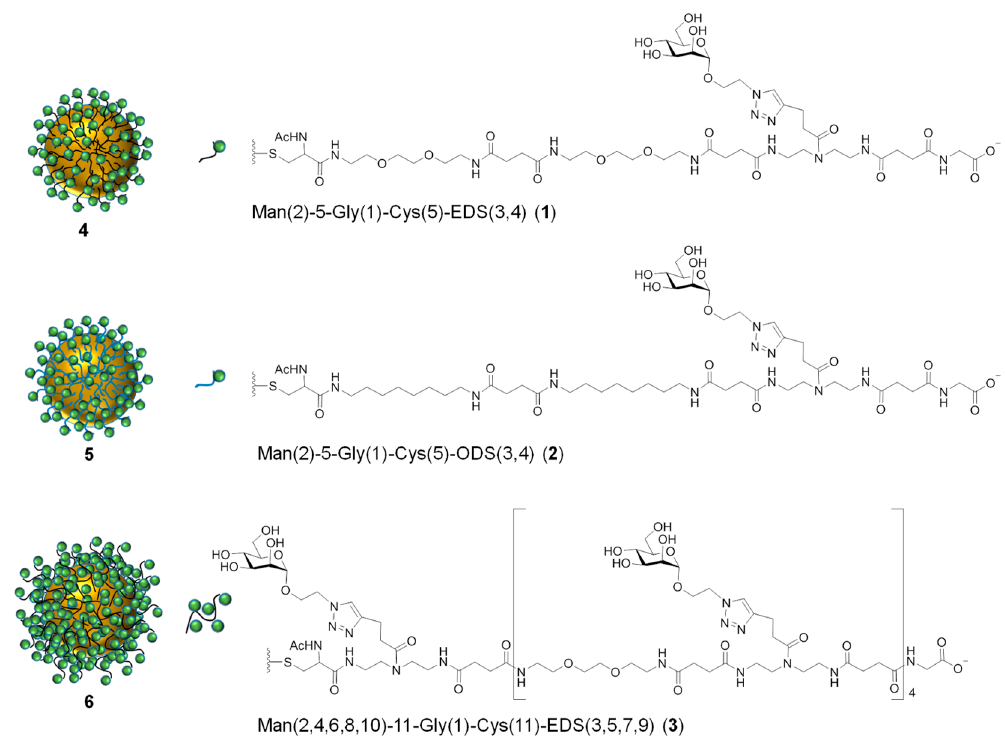
Figure 2. Chemical structure of precision glycomacromolecules 1 – 3 and schematic presentation of the associated glyco-AuNPs 4 – 6 .